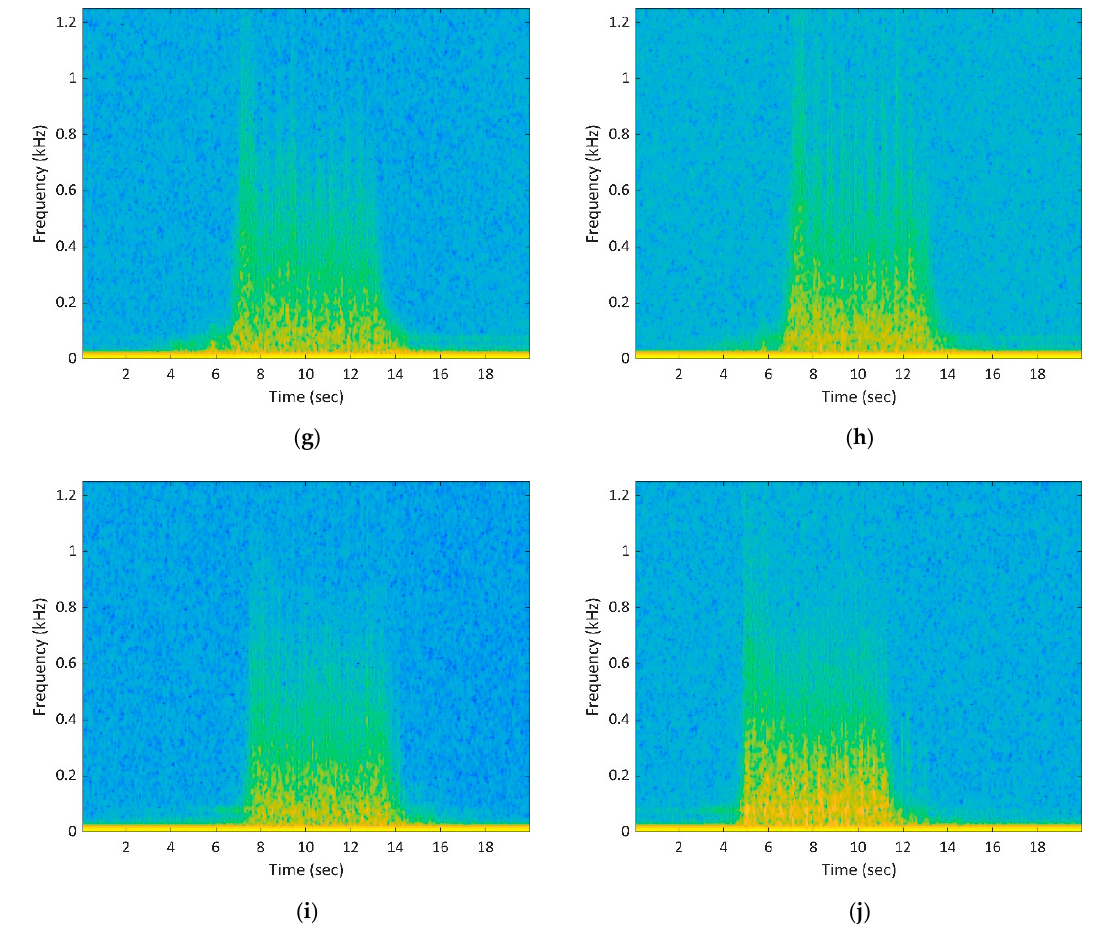
Figure 6. Spectrograms of two train journeys in the same composition in 5 consecutive channels distributed equidistantly. ( a ) Channel 300, Train journey 1; ( b ) Channel 300, Train journey 2; ( c ) Channel 325, Train journey 1; ( d ) Channel 325, Train journey 2; ( e ) Channel 350, Train journey 1; ( f ) Channel 350, Train journey 2; ( g ) Channel 375, Train journey 1; ( h ) Channel 375, Train journey 2; ( i ) Channel 399, Train journey 1; ( j ) Channel 399, Train journey 2.